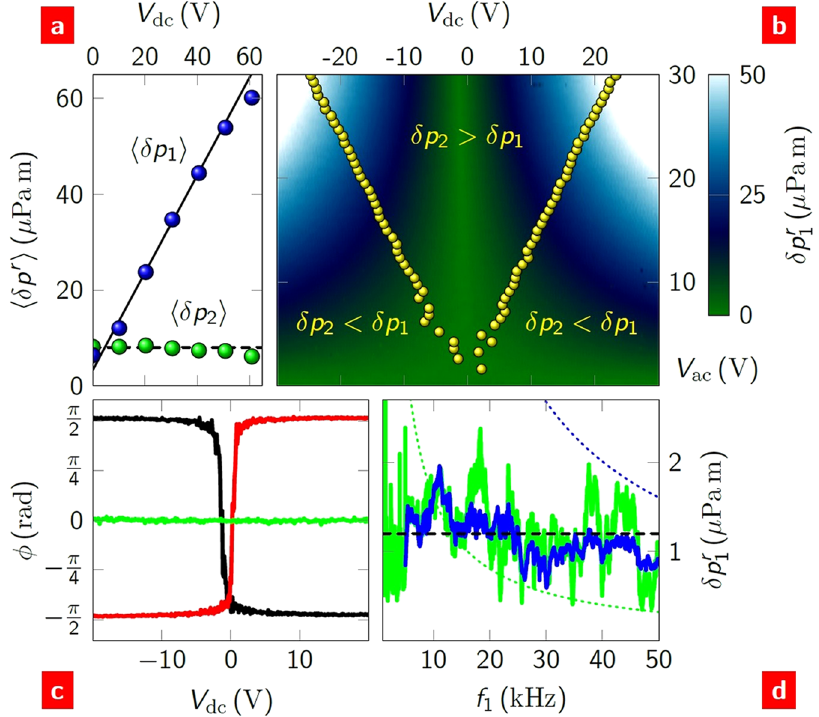
Figure 3. Bias control of the first harmonic generation. ( a ) Sound pressure measured at the first (blue) and second (green) harmonics of the source frequency as a function of dc bias across a back-gated FET. The sound pressure values are averaged over the frequency ranges f i = 38–42 kHz, i = 1, 2. The solid line is a linear fit to the first harmonic data; the dashed line is 〈 δ p 〉 = 8 μ Pa. P 2 was fixed at 0.1 W for all measurements. ( b ) The first harmonic sound as a function of both ac and dc bias at f = 12 kHz. The second harmonic sound increases quadratically with V ac : the yellow symbols indicate where, experimentally, δ p 1 = δ p 2 . ( c ) The phase of the first (black at f 1 = 12 kHz; red at f 1 = 15 kHz) and second (green) harmonic as a function of dc bias. ( d ) Example of a flat first harmonic sound spectrum (solid lines) created by decreasing the dc bias as V dc = V ref ( f ref / f ), where V ref = 10 V at f ref = 1 kHz. The ac bias was fixed at 10 V. The applied dc biases are shown (in Volts) as dotted lines in colours corresponding to the sound spectra, which have been normalised to V ref for